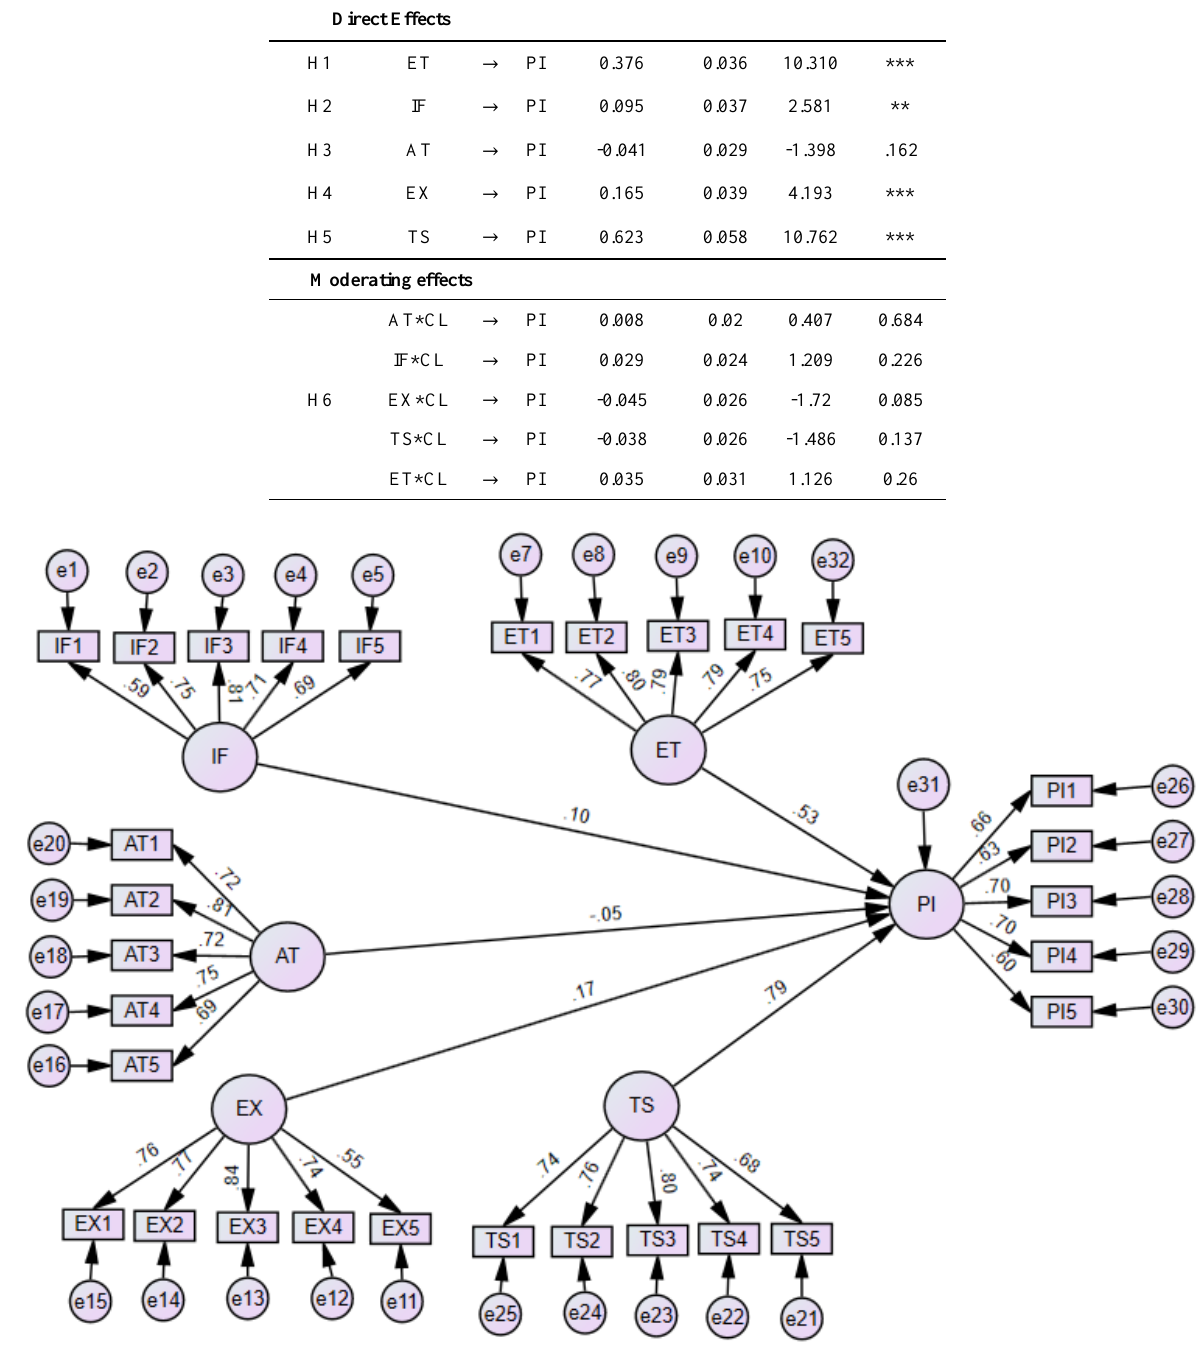
Figure 2. Hypothesis Evaluation and SEM